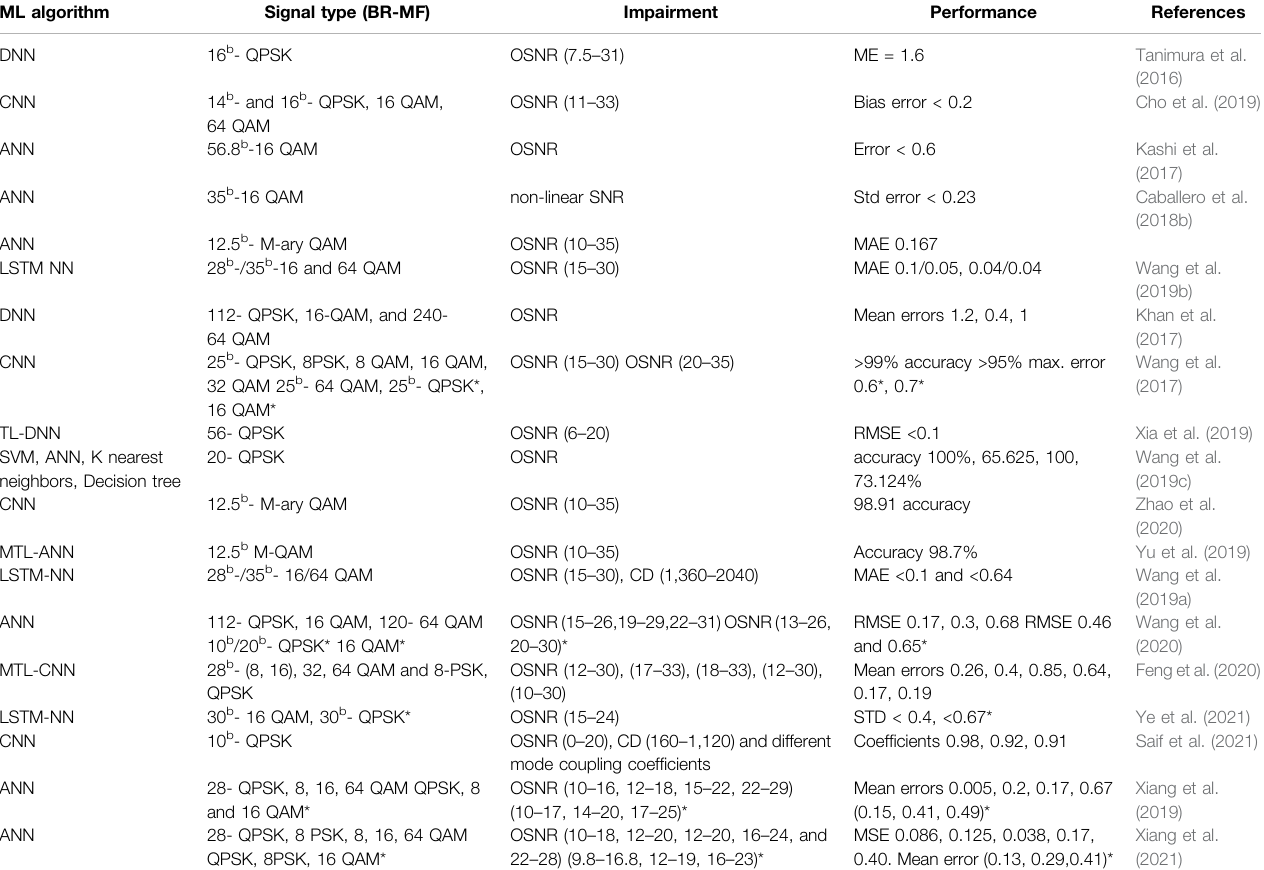
TABLE 4 | Summary of existing OPM works-coherent